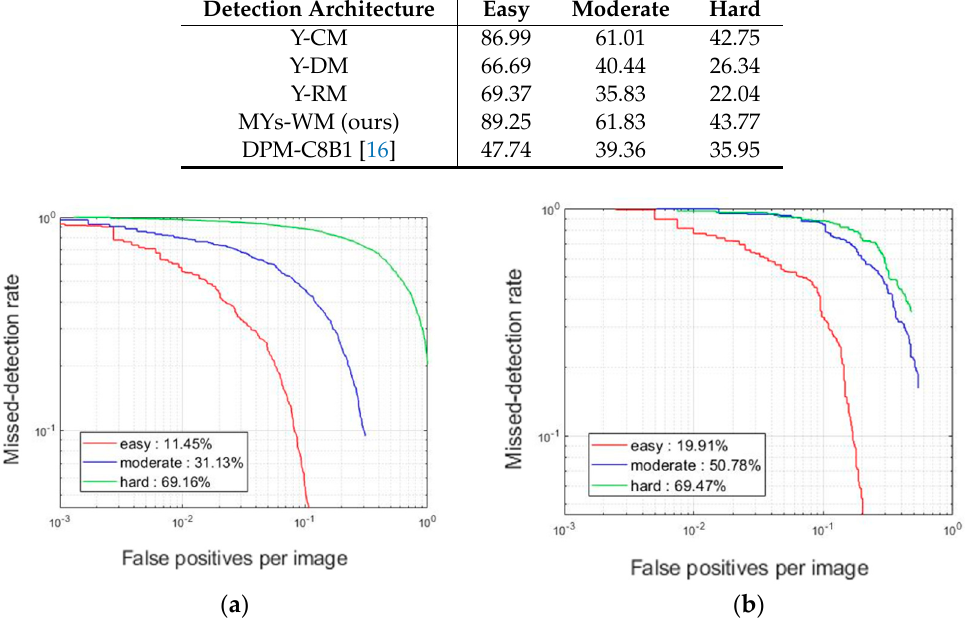
Figure 10. Missed-detection rate by MYs-WM according to difficulty. ( a ) car; ( b ) pedestrian.